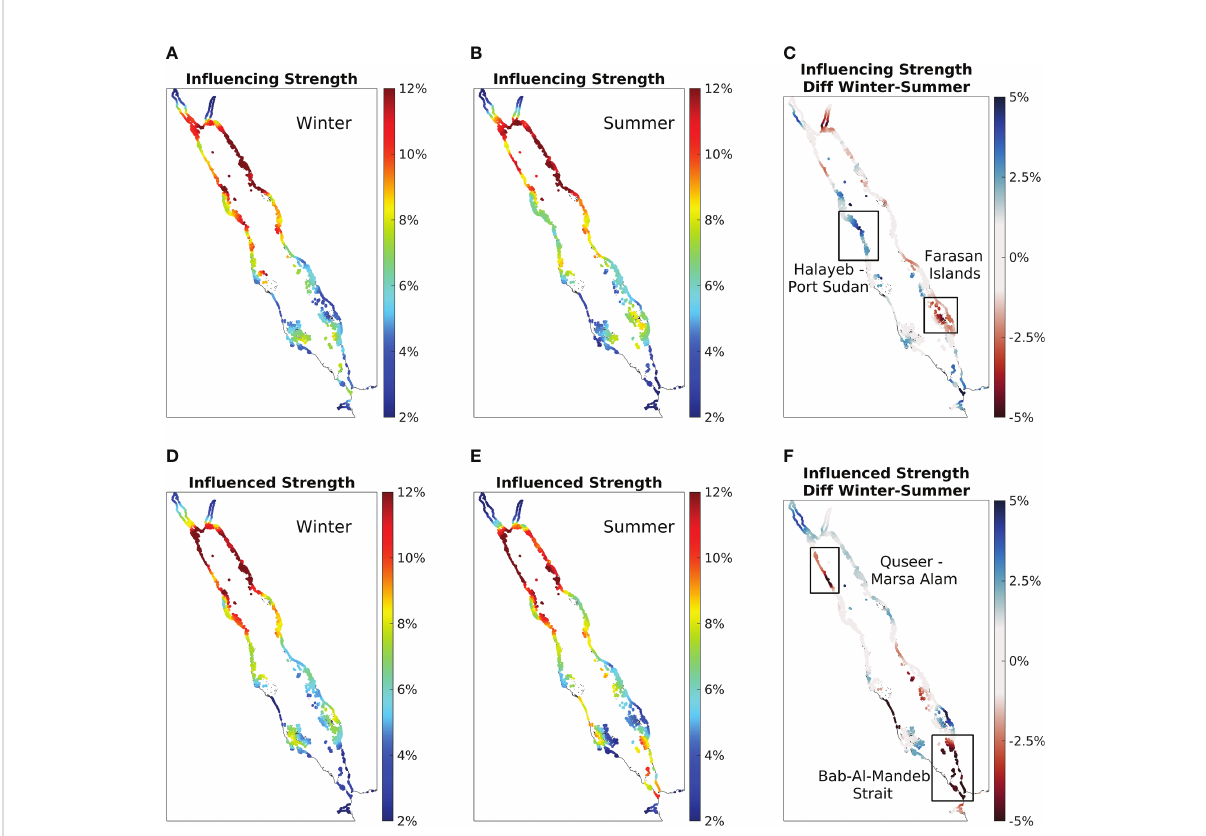
FIGURE 4 The seasonal physical connectivity atlas of the Red Sea coral reefs. (A) Winter in fl uencing strength is calculated based on simulations conducted during winter with particles being released in January and tracked for 30 days. Similar to the annual analysis, the value is the average over 13 Januarys during the 13 simulation years. (B) Same as (A) , except for particles being released in July to represent summer. Colours indicate the percentage of connected coral reefs, where a higher value implies that the reef site is a better source (in A and B) or destination (in D and E) for the all Red Sea reefs. (C) Differences between winter and summer of in fl uencing strength , with a positive value indicating a higher in fl uencing strength during winter. Panel (D – F) are the same as panel (A – C) , but showing in fl uenced strength instead. January and July were chosen to represent the winter and summer seasons, respectively, as the maximum differences were observed during these months (see Figure S6 for the monthly in fl uencing strength and in fl uenced strength from January to